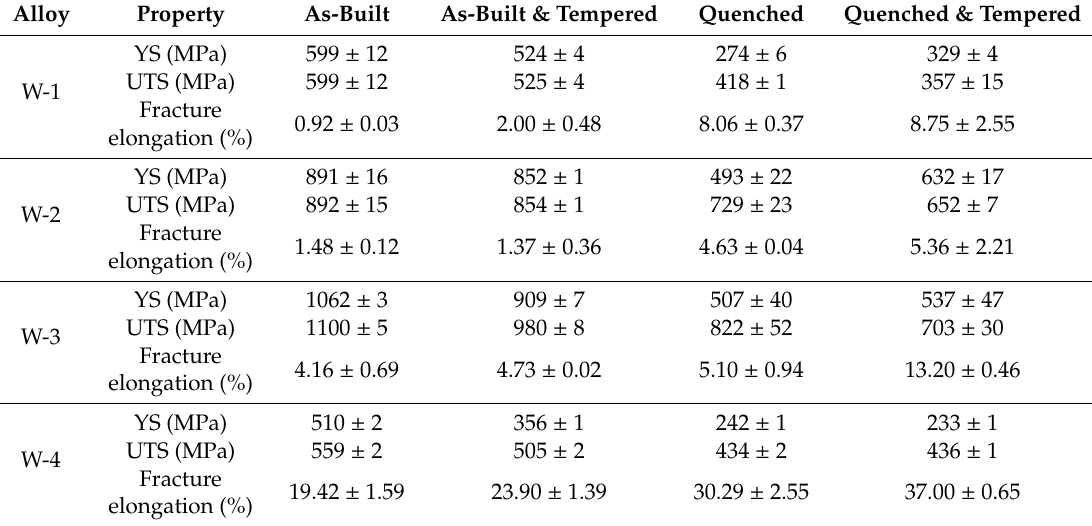
Figure 12. Tensile curves of ( a ) W-1, ( b ) W-2, ( c ) W-3 and ( d ) W-4 steels (dashed-lines represent the test duplication). Table 6. Tensile properties of the W-series L-PBF processed steels.